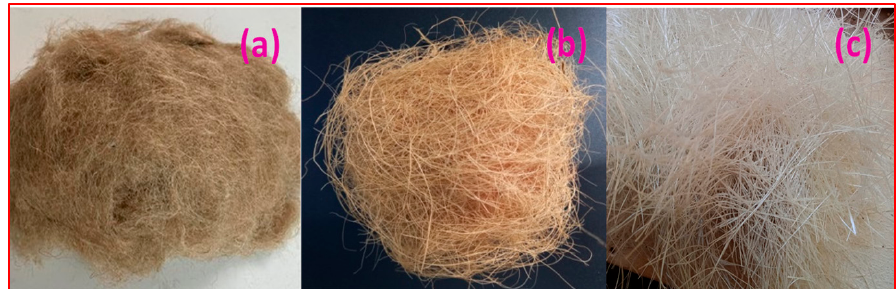
Figure 2. SEM Image of eggshell powder.